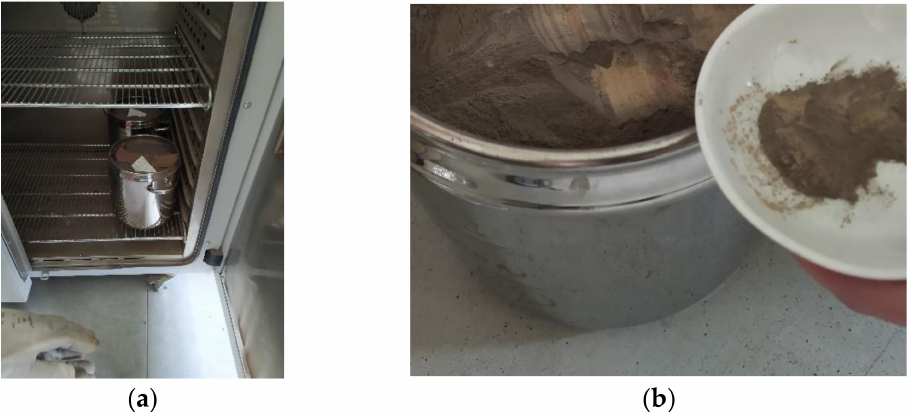
Figure 1. ( a ) Thermal loading of bentonite powder in open vessels, and ( b ) visible colour change from light brown to dark brown at the powder surface observed during